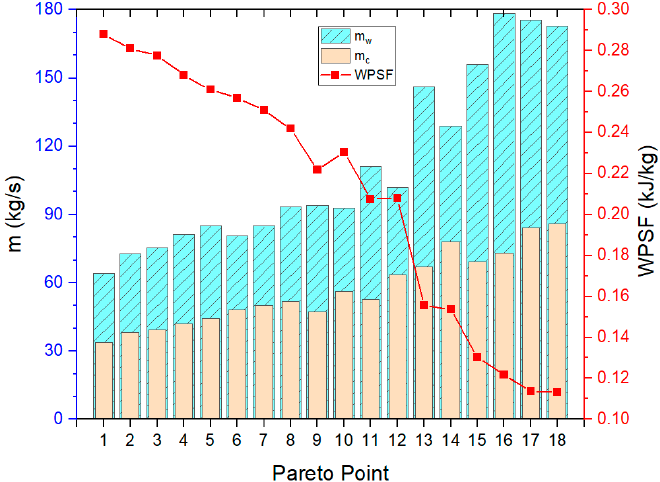
Figure 7. The seawater flow rate and the net output power per unit seawater flow rate at the Pareto frontier point.